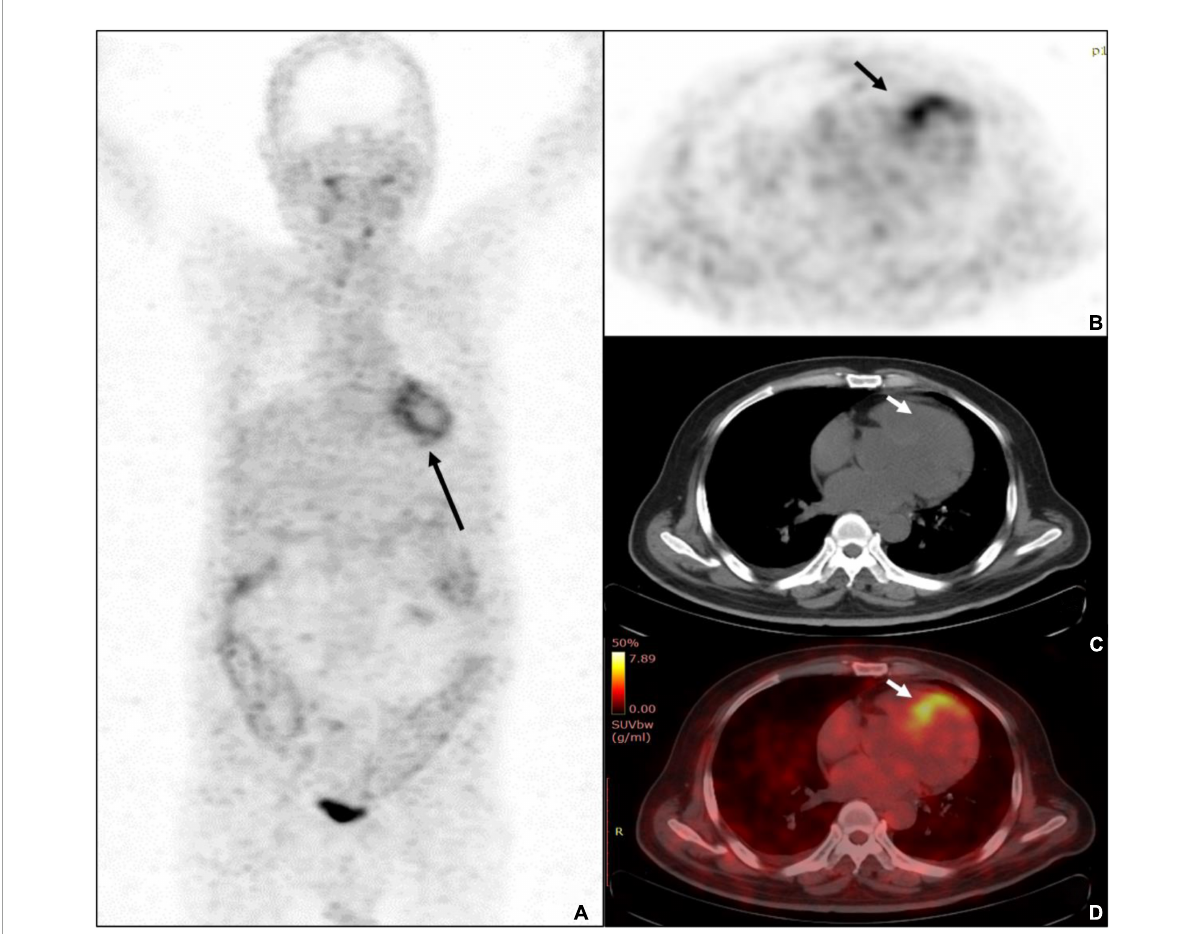
FIGURE2 A 68-years-old male patient was diagnosed with ulcerative colitis and diabetes mellitus. (A) The whole-body MIP of Al 18 F-NOTA-FAPI-04 PET imaging demonstrated diffused uptake pattern in LV (black arrow) and diffused uptake with colons. (B) The PET imaging showed the highest uptake of SUVmax was 7.0 (black arrow). (C) Unfused CT image of the heart. (D) The fusion imaging showed the septal wall of prominent uptake of